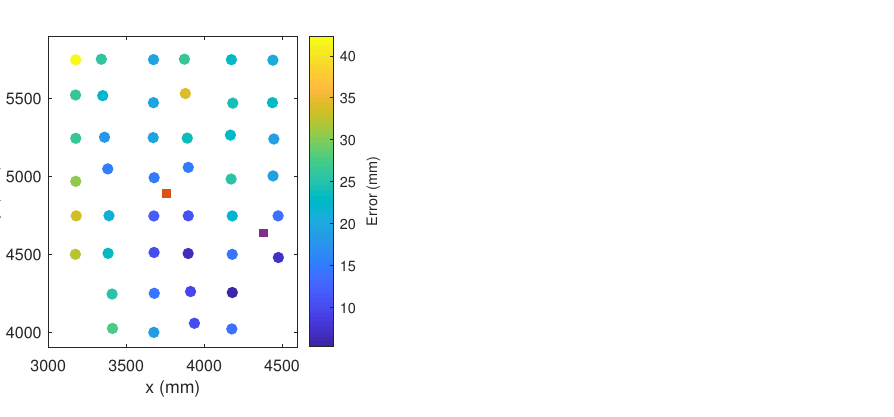
Figure 8. Receiver positioning errors shown graphically by calculating the height.